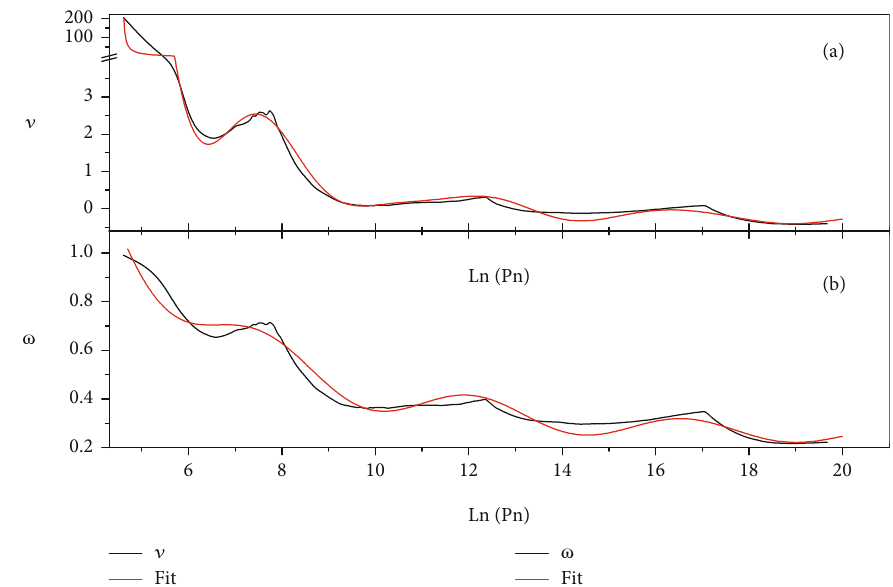
Figure 12: (a) The relation between the natural logarithm of the accumulated prime numbers from100 to 350 million primes and the inverse χ 2 parameter ν and the fi tted values using Equation (11). (b) The relation between the natural logarithm of the accumulated prime numbers from 100 to 350 million primes and the Brody parameter ω and the fi tted values using Equation